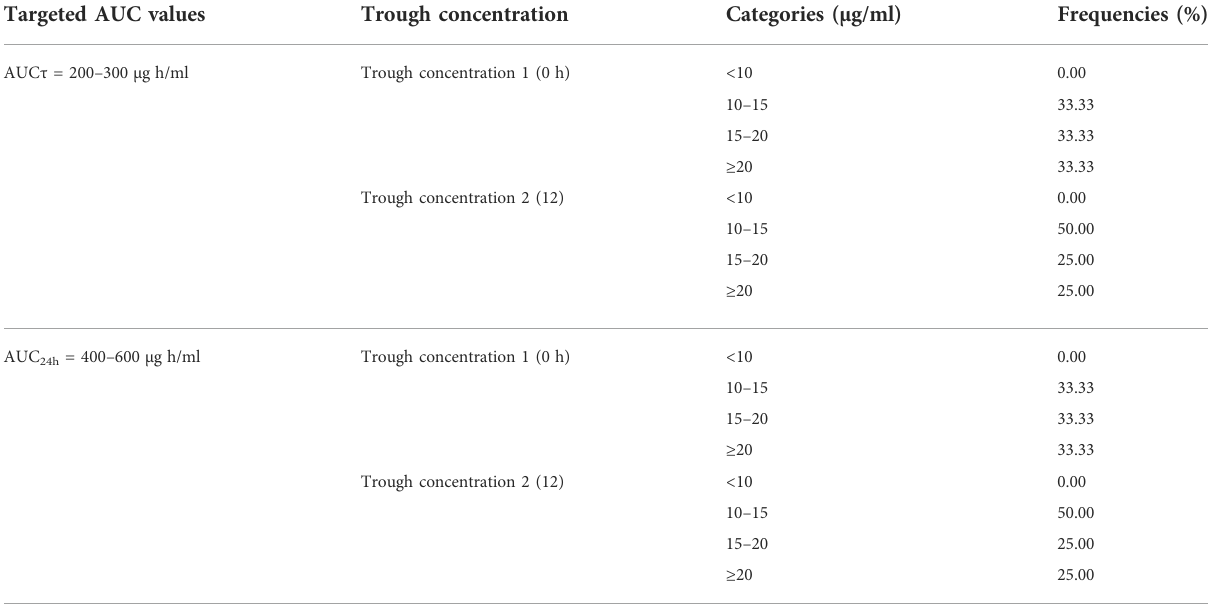
TABLE 6 Trough levels in patients with targeted AUC values ( N = 12).